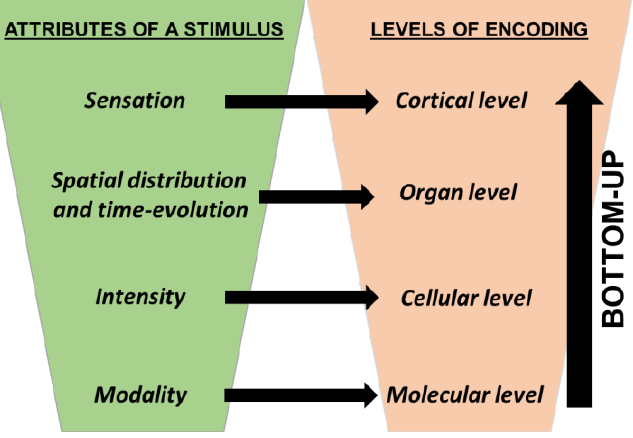
Figure 7. Hierarchical mechanism of encoding the information of a stimulus.